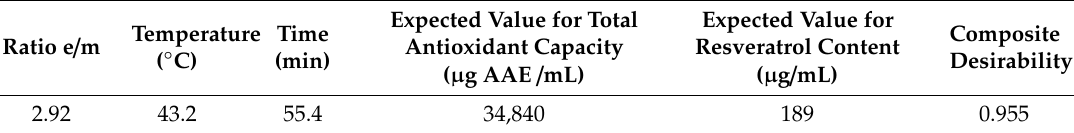
Table 5. Response optimization: TAC, resveratrol solution.